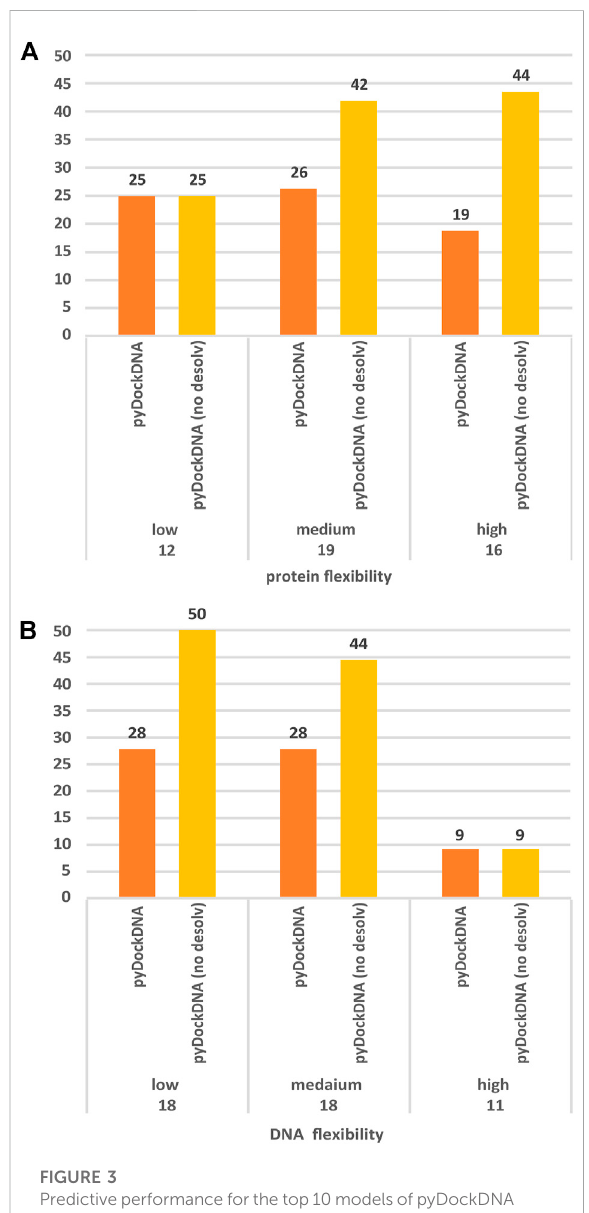
FIGURE 3 Predictiveperformance forthetop10modelsofpyDockDNA (with and without desolvation) on the protein-DNA docking benchmark when cases are grouped according to (A) protein fl exibility (low: RMSD < 1 Å; medium: 1Å ≤ RMSD < 3 Å; high: RMSD ≥ 3 Å), and (B) DNA fl exibility (low: RMSD < 3 Å; medium: 3 Å ≤ RMSD < 5 Å; high: RMSD ≥ 5 Å). See more details about fl exibility de fi nition in main